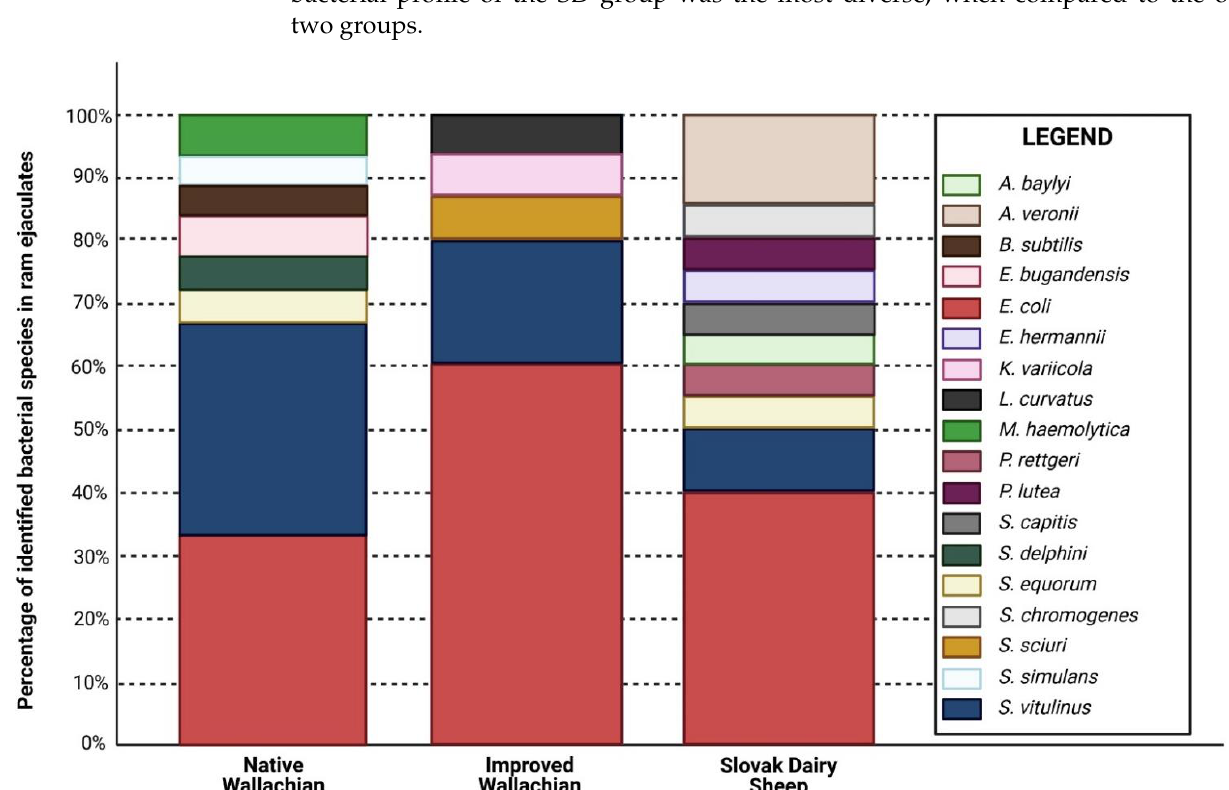
Table 2. Bacterial biodiversity characteristics of the pre-established groups of ram semen samples.